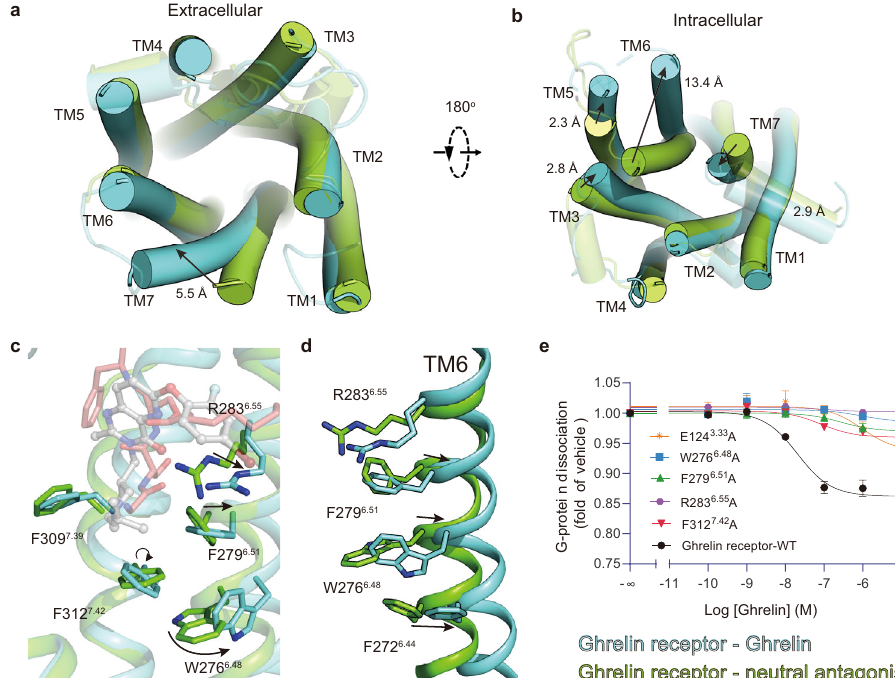
Fig. 4 Mechanism of ghrelin action on ghrelin receptor. a , b Structural comparison of agonist-bound with neutral antagonist-bound structures (PDB: 6KO5) reveals remarkable displacements in the extracellular side ( a ) and intracellular side ( b ), resulting in contracting of the orthosteric binding pocket in the extracellular side as well as making a cavity to couple G protein in the intracellular side. c Superposition of ghrelin-bound (aquamarine cartoon) and neutral antagonist-bound (forest cartoon) structures shows that the WFF cluster exhibits obvious conformational displacements upon ghrelin binding. d The rearrangement of local residues in the backbone of TM6 between ghrelin-bound (aquamarine cartoon) and neutral antagonist-bound (forest cartoon) structures (PDB: 6KO5) shows the cascade changes of residues R283 6.55 , F272 6.44 , and the WFF cluster. e Mutations of W276 6.48 , F279 6.51 , and F312 7.42 in the ghrelin receptor decreased the activation potency induced by ghrelin. Data represent the mean ± SEM from n = 3 biologically independent experiments performed in triplicate. See also Supplementary Figs. 6 and